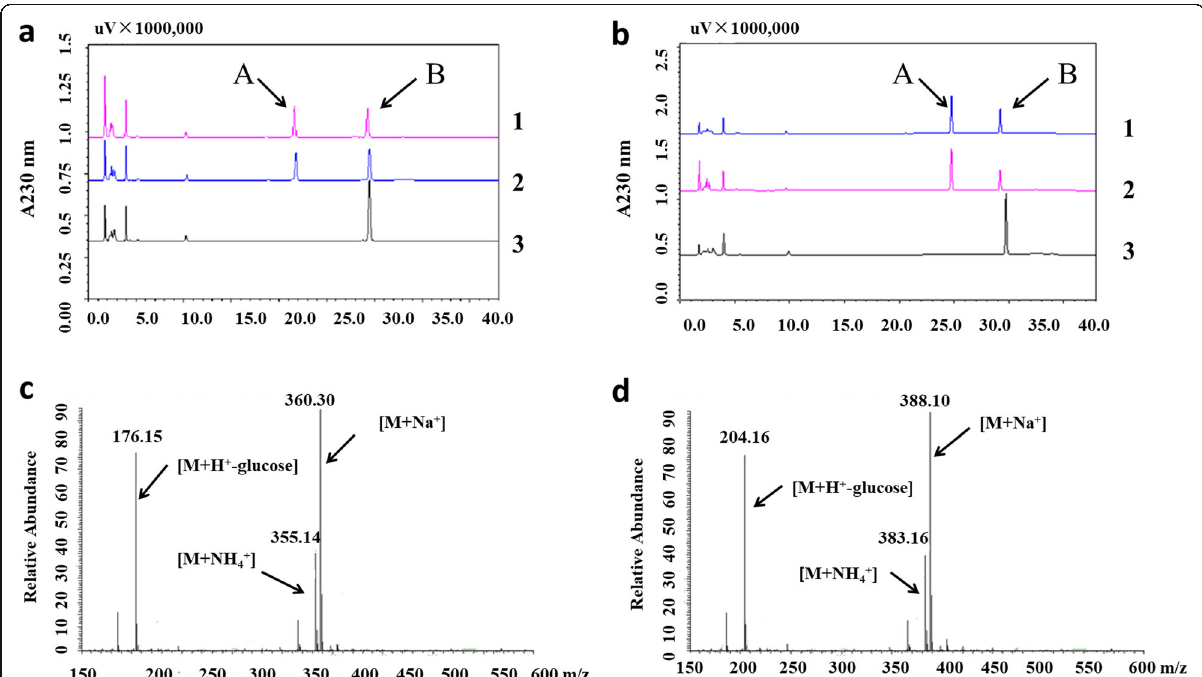
Fig. 3 HPLC and LC-MS analysis of reaction products from IAA and IBA catalyzed by OsIAGT1. a and b HPLC analysis of reaction products from IAA and IBA, respectively. 1, 2, 3 denote the reactions with recombinant protein OsIAGT1, UGT74D1 (positive control), GST (negative control), respectively. “ A ” denotes the possible products; “ B ” denotes the substrate IAA or IBA. c and d LC – MS analysis of reaction products from IAA and IBA,